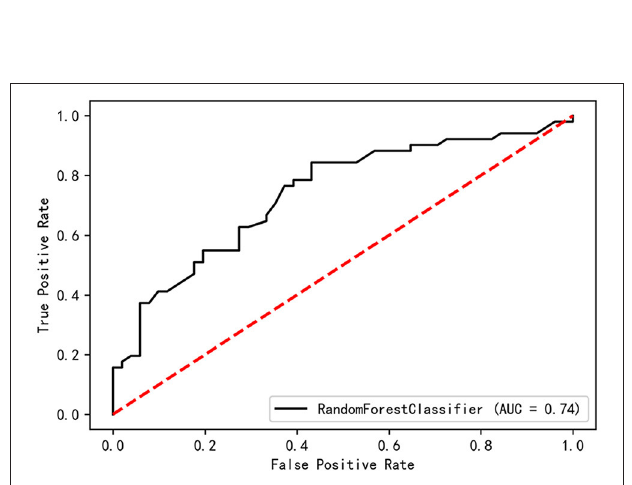
FIGURE 6 | Receiving operating curves (ROC) of Random Forest